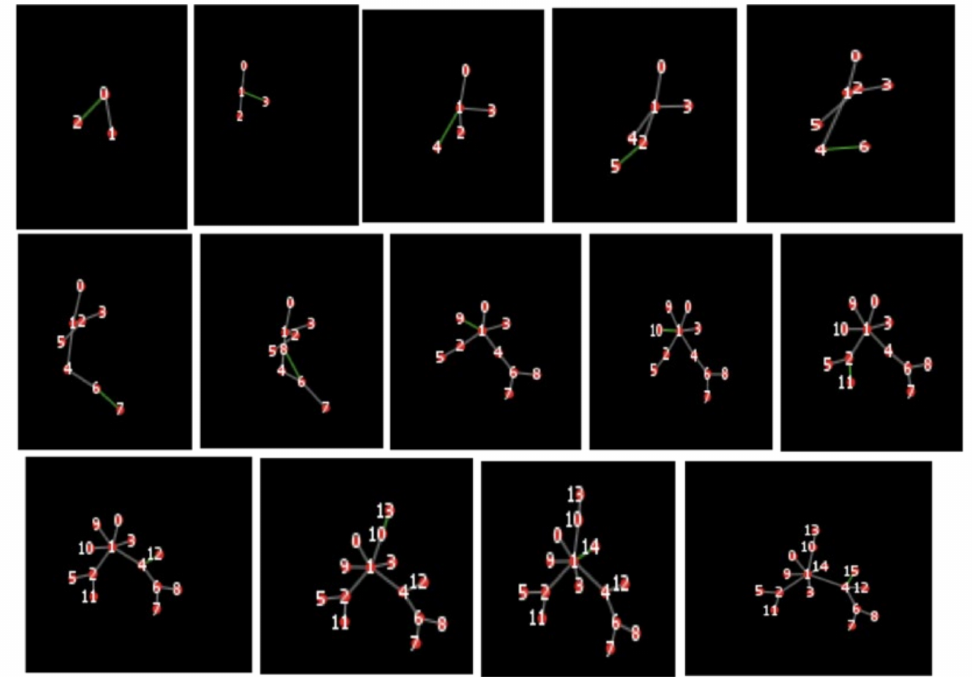
Figure 3. Emergence of network based on preferential attachment phenomenon. To analyze the flow of information generated from one node to another of the net- work based on the individual node degree evolution over several time-steps of network formation, the concept of transfer entropy (TE) is used. To generate TE values based on individual node degree evolution, data on the number of nodes present along with the individual node degrees over 15 different time-steps were captured using NetLogo [35]. Table 2 illustrates the degree evolution of nodes portrayed in Figure 3. Table 2. Time series showing the node degrees generated at each time-step.